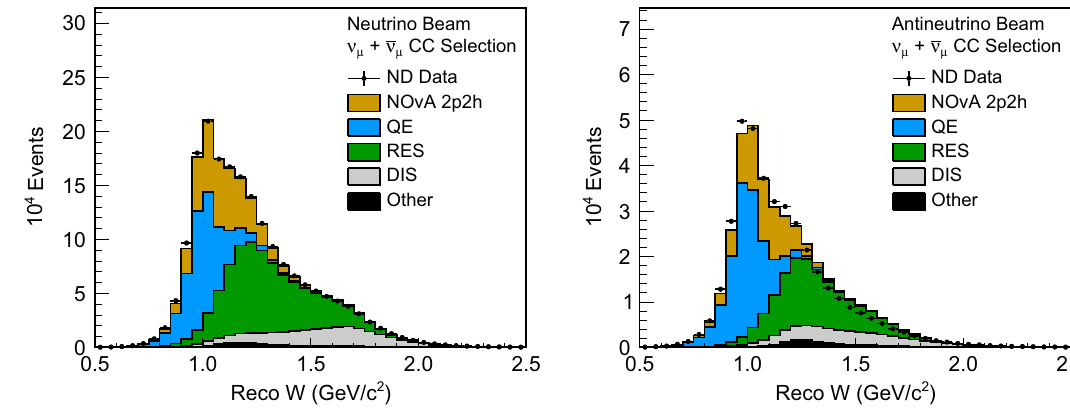
Fig. 16 Comparison of fully adjusted simulation to data in reconstructed W, for neutrino beam (left) and antineutrino beam (right)